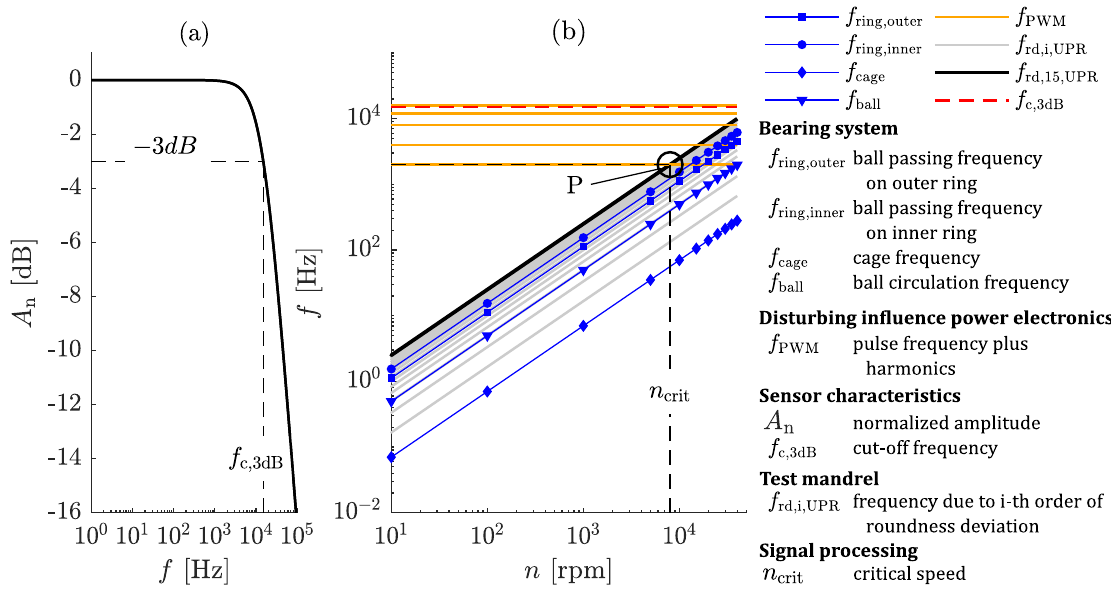
Figure 4. ( a ) Approximated frequency response of capacitive sensor; and ( b ) exemplary frequencies occurring in spindle measurements due to influences of power electronics, ball bearings, and target form